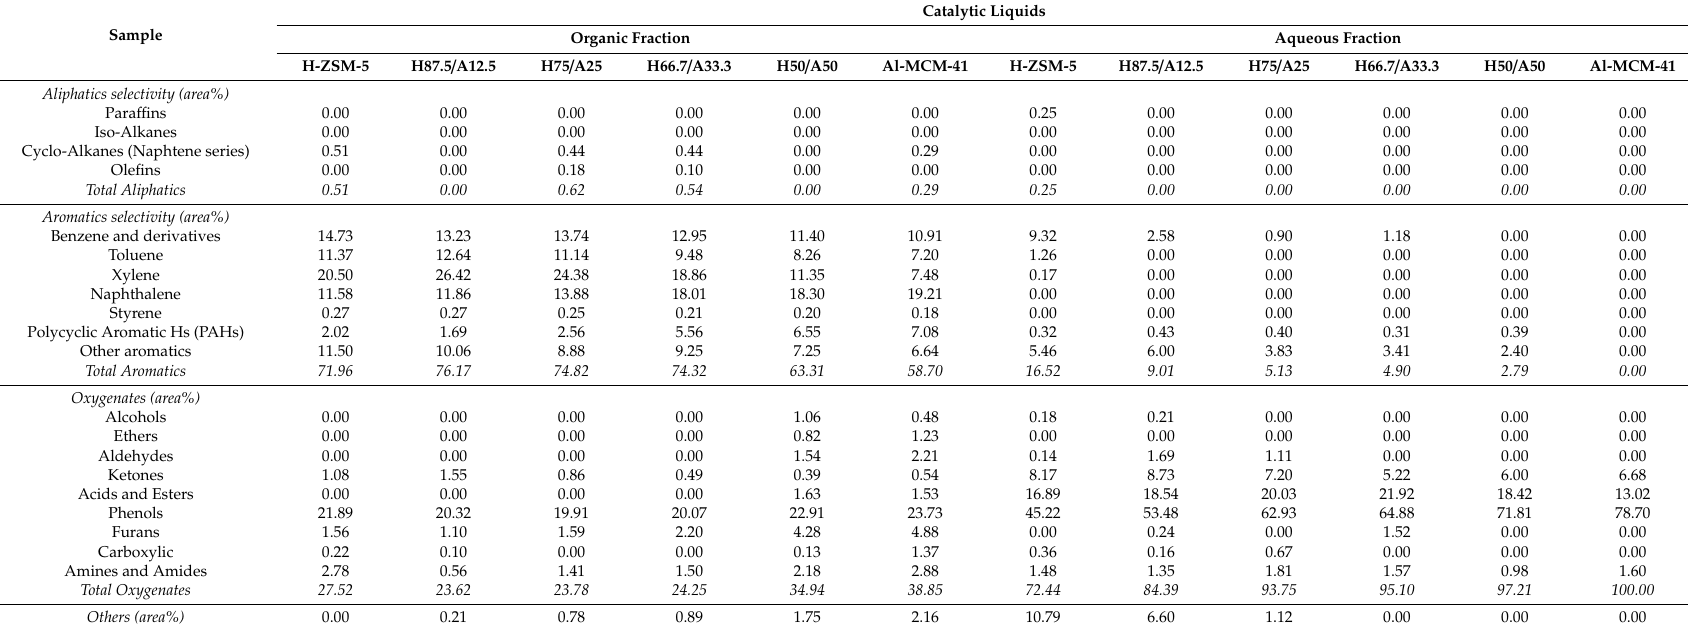
Table 3. Detailed chemical compositions (area%) of the Organic Fraction (OF) and Aqueous Fraction (AF) for catalytic pyrolysis of lignocellulose biomass.